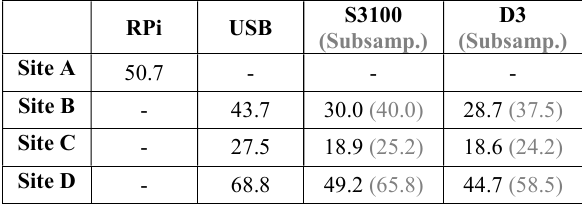
Table 4. Estimated precision of image blocks (in mm) based on Eq.